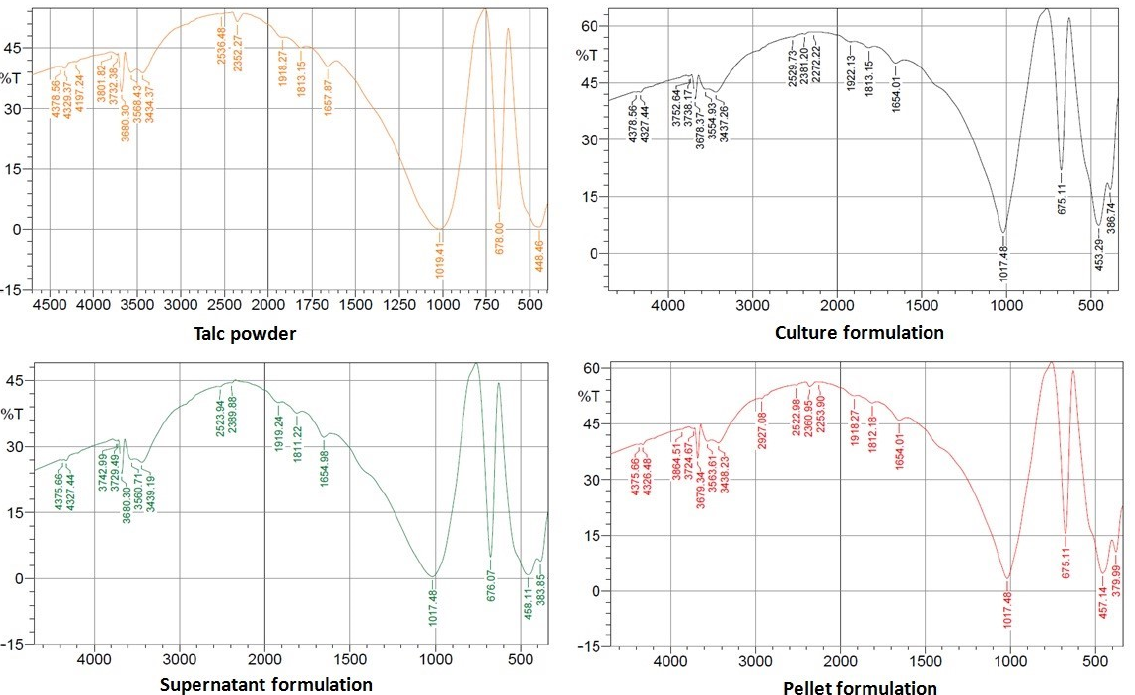
Figure 5. Fourier transform infrared spectroscopy (FTIR) spectrum of talc-based formulations of Streptomyces cellulosae Actino 48.